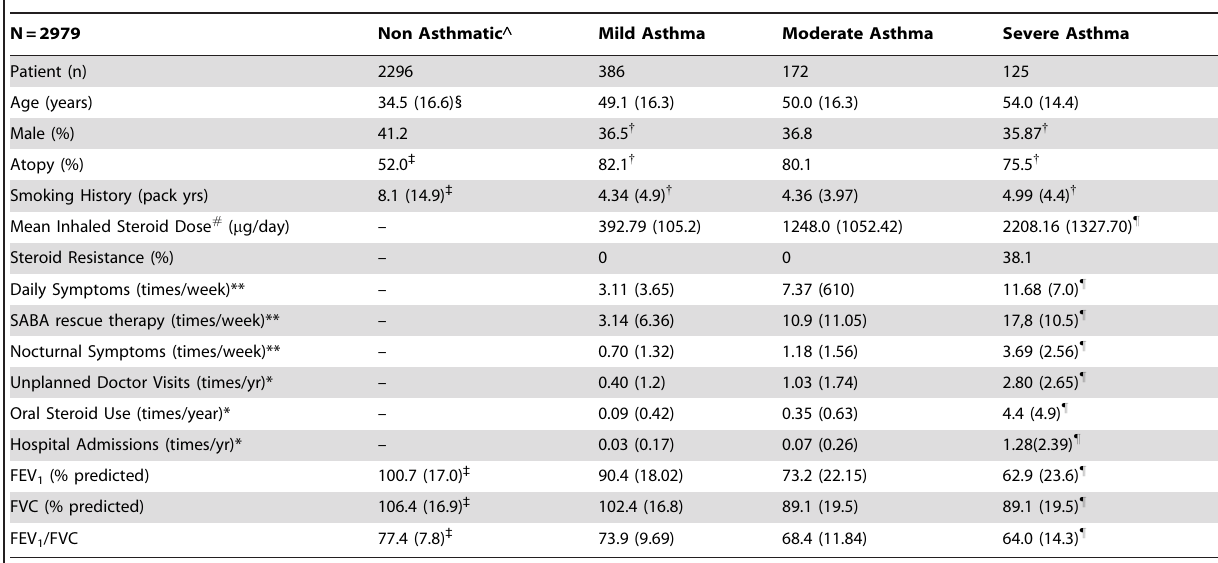
Table 2. Characteristics of Study